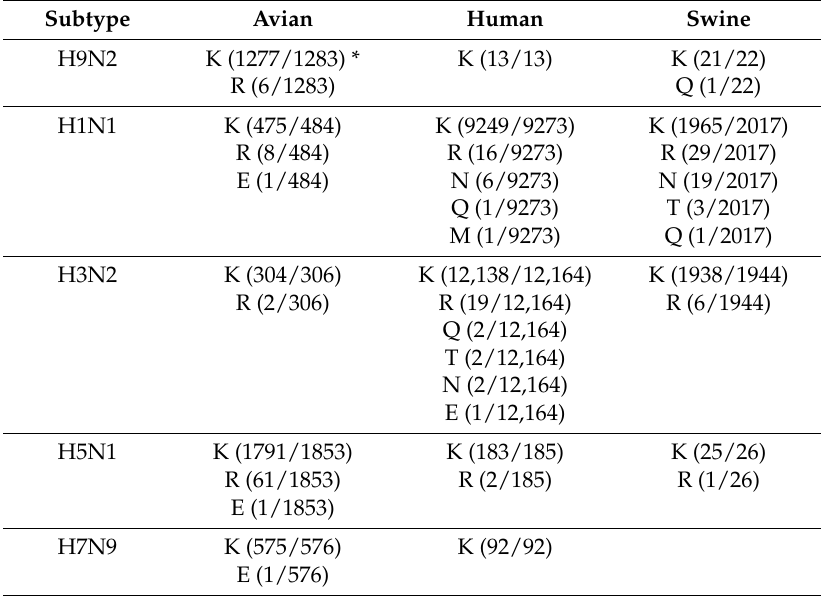
Table 2. Amino acids at position 577 in PB1 of avian, human, and swine influenza virus strains.